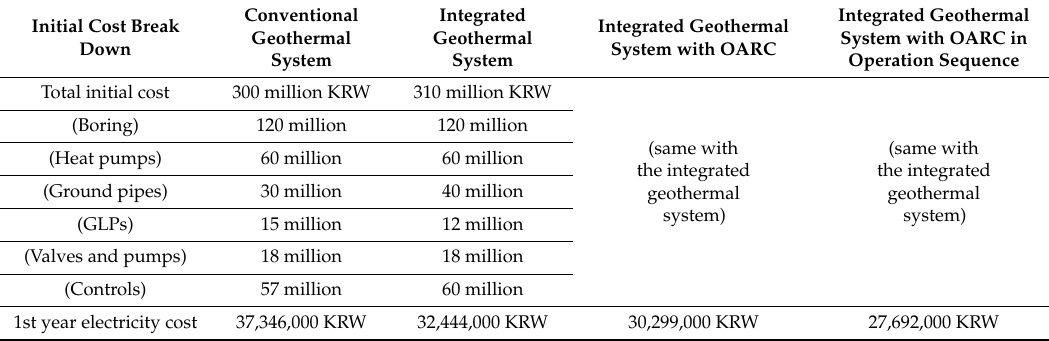
Table 6. Cost breakdowns for the four system configurations (KRW: South Korean